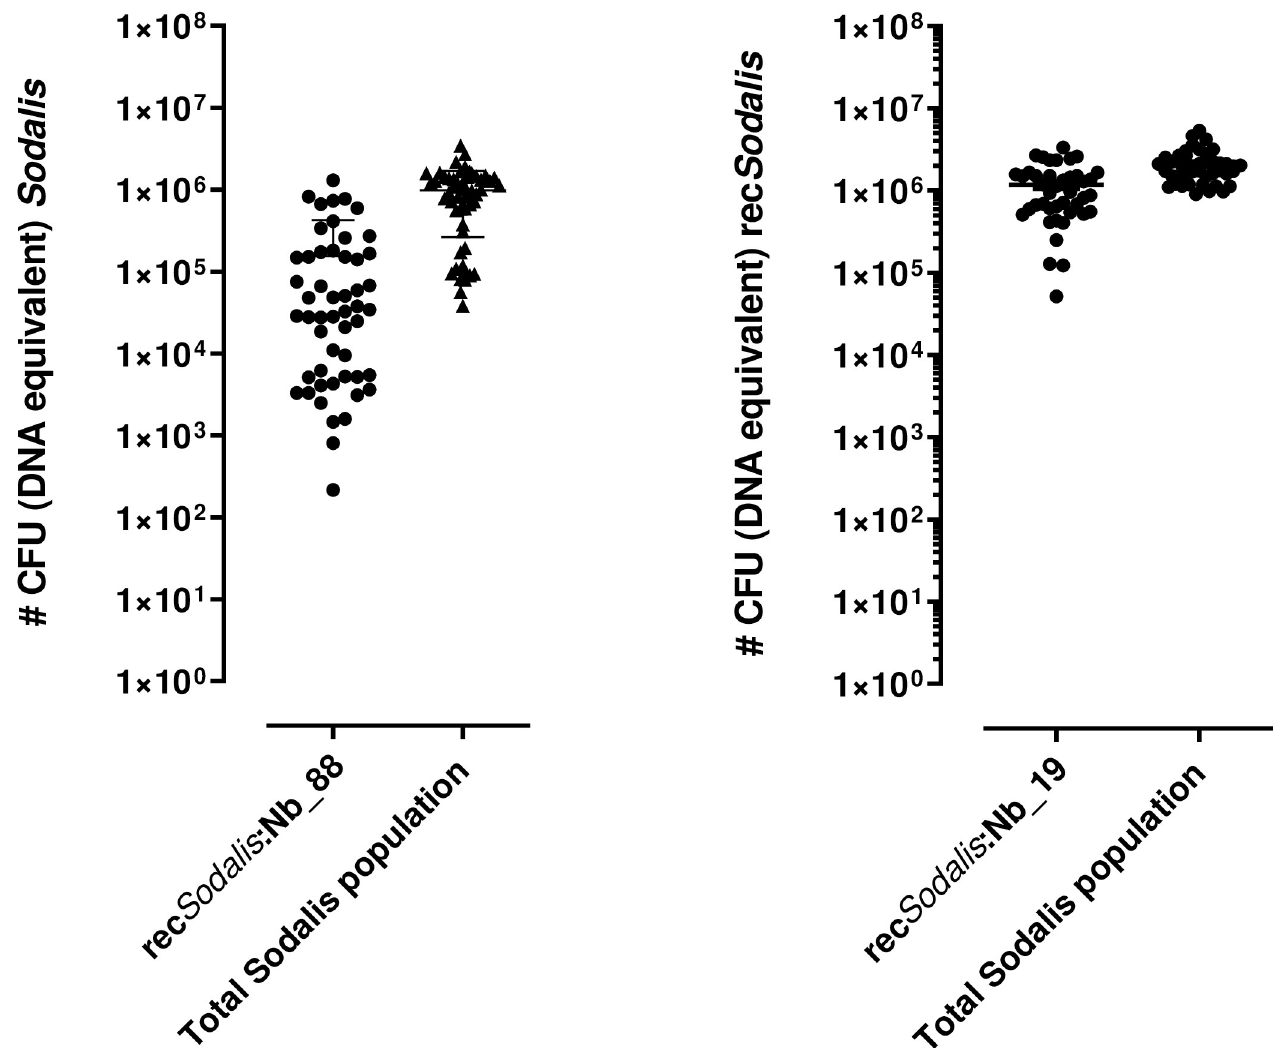
Fig 5. Midgut characteristics of rec Sodalis colonized male flies. Graphs depict the number of rec Sodalis CFU (DNA equivalent) versus the total number of Sodalis CFU (DNA equivalent) (WT + recombinant Sodalis) present in the midgut of 4 weeks-old male flies emerged from larvae injected with 5 × 10 6 rec Sodalis ::Nb_88 (n = 50) (left graph) or rec Sodalis ::Nb_19 (n = 42) (right graph). The number of WT and rec Sodalis CFUs was estimated using an already validated quantitative real-time qPCR protocol (8). The number of CFUs is represented in log scale on the y-axis. Error bars represent mean with standard deviation (SD) and are based on at least two independent experiments.